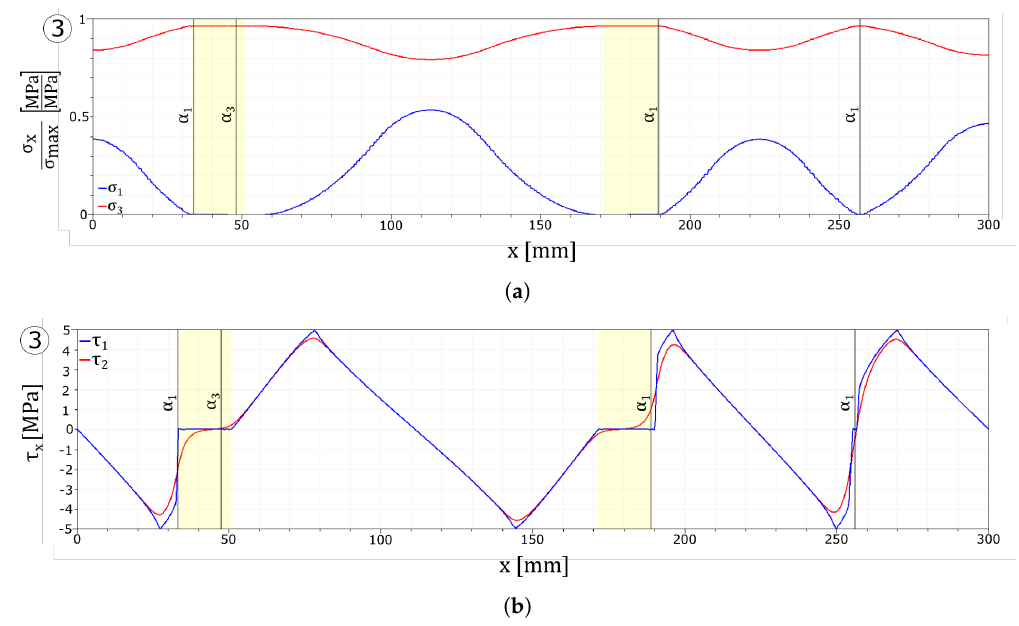
Figure 6. Numerical results of the UD reference test: stresses plot. ( a ) Glass plies stress profiles. ( b ) Interface stress profiles.